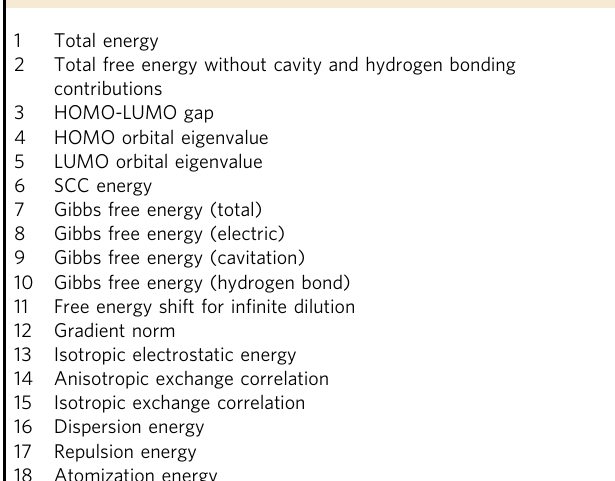
Table 3 List of energy components of the implicitly perturbed Hamiltonian employed as molecular